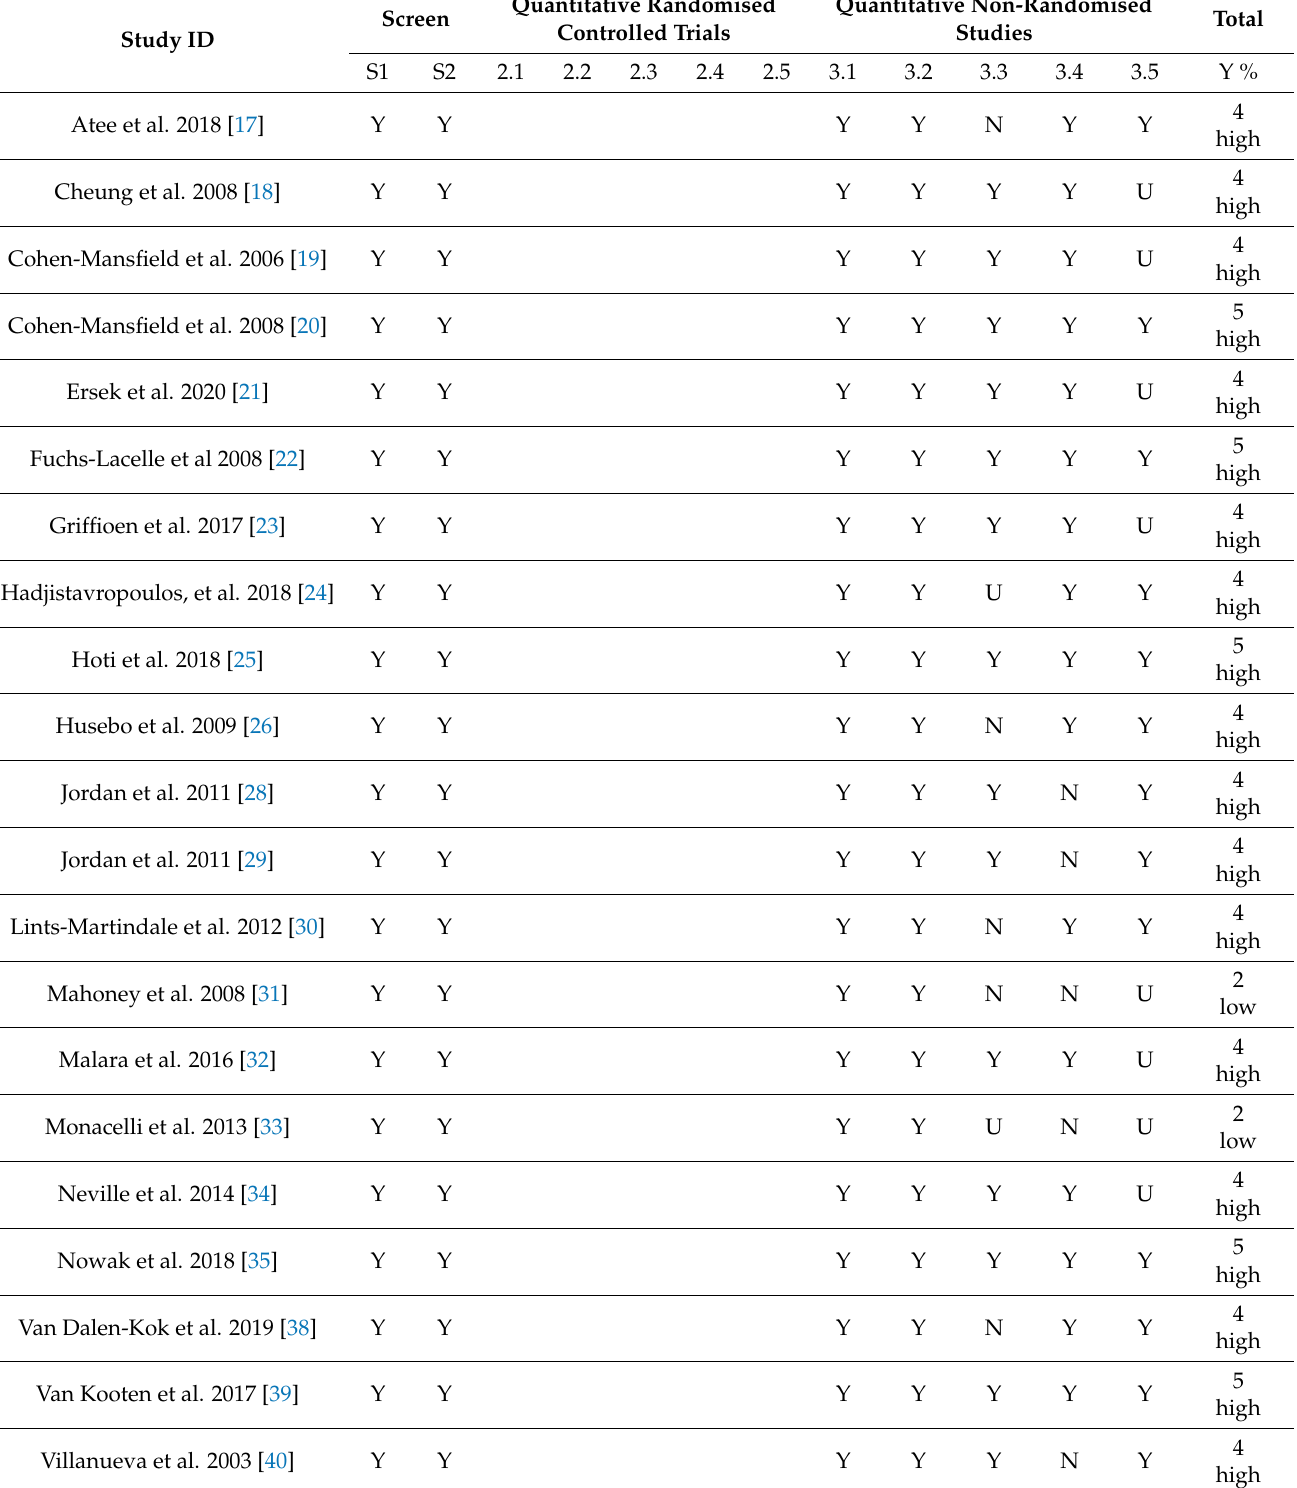
Table 3. Quality of studies analysis using the Mixed Method Appraisal Tool (MMAT)